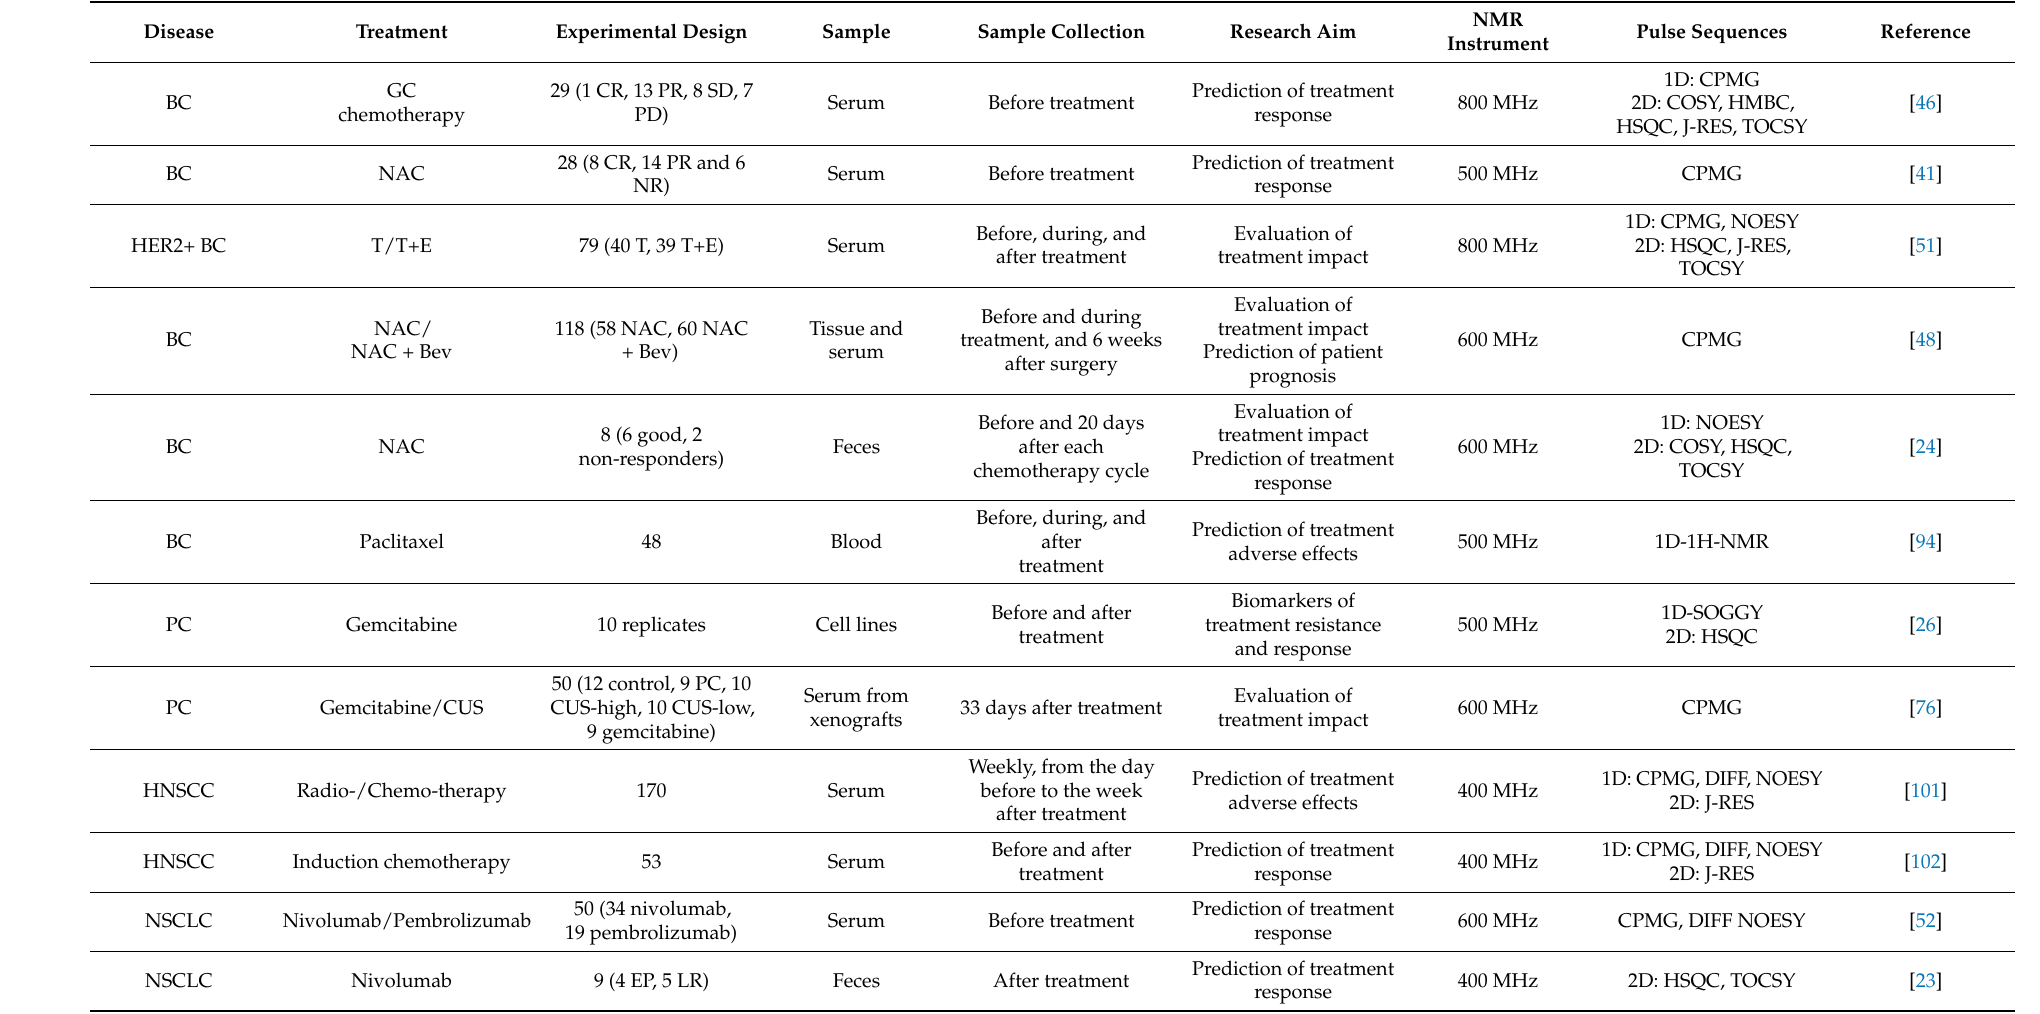
Table 1. Overview of the PMx studies focused on the oncology